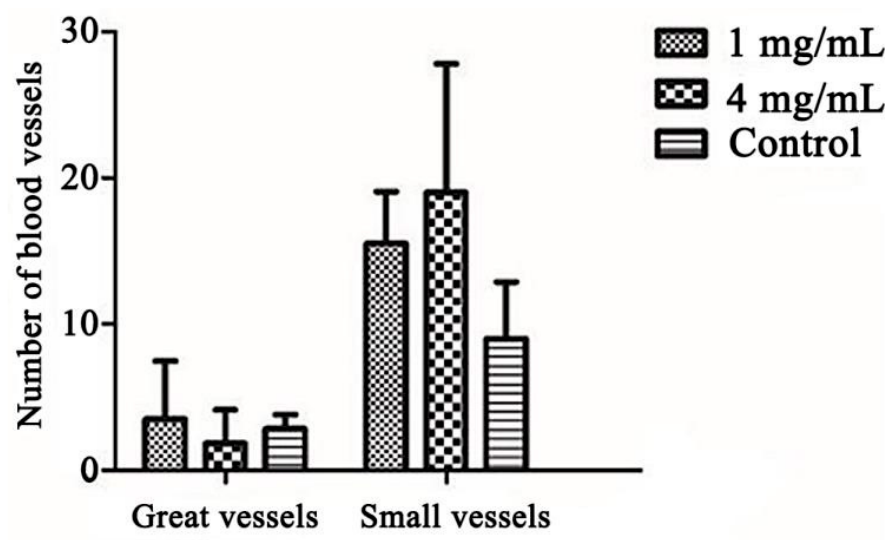
Figure 5. Compound DG-15 increased the number of blood vessels with different concentrations: 1 mg/mL; 4 mg/mL and Control group.